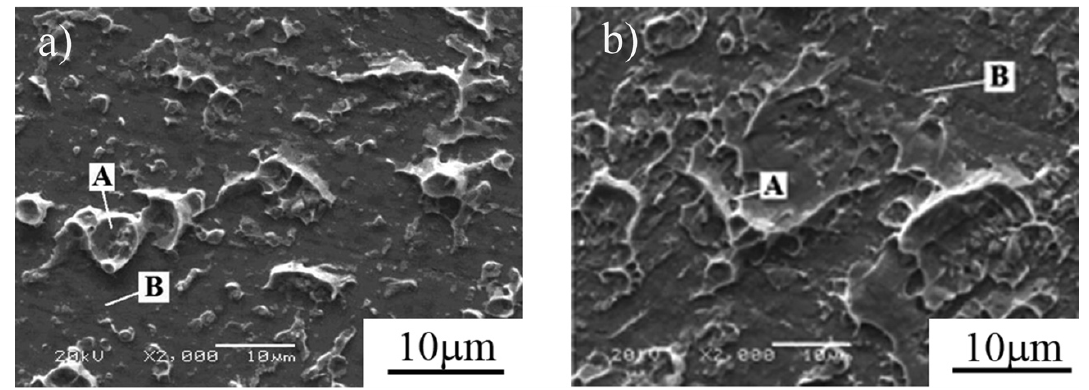
Figure 14. Effect of electrical field intensity on fracture of 40Cr side. ( T = 740 °C, t = 4 min, P 0 = 56.6 MPa, ε(cid:4662) (cid:2868) = 1.5×10 − 4 s − 1 ). ( a ) E = 0 kV/cm, ( b ) E = 3 kV/cm.